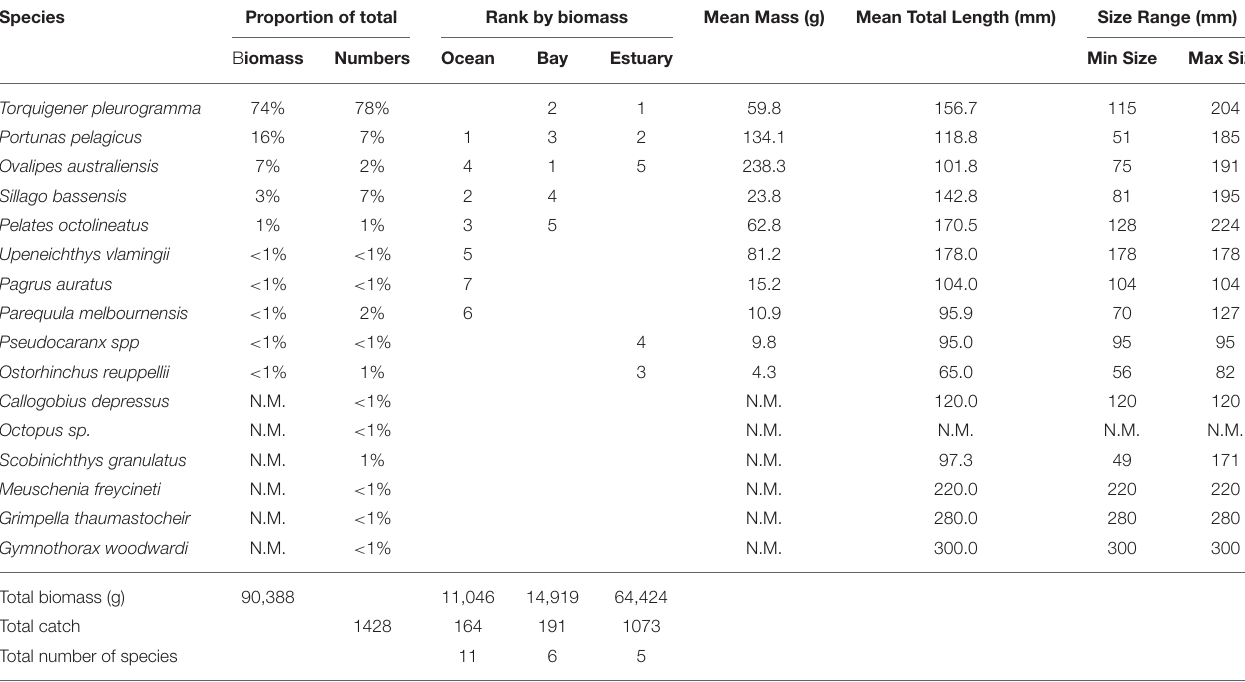
TABLE 3 | Proportion contribution of each species to the total catch in traps by biomass (g) and numbers, and the rank by biomass in the Ocean, Bay, and Estuary.